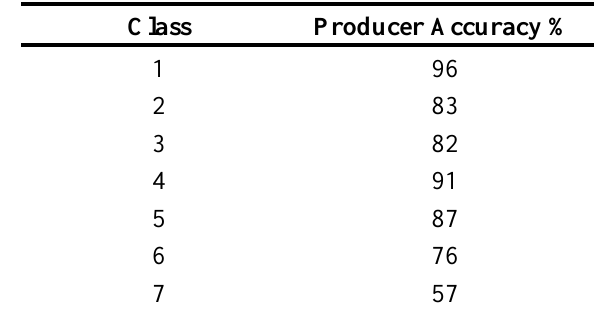
Table 3. The result of the producer and user accuracy of classified classes in the Western Qatar Peninsula.